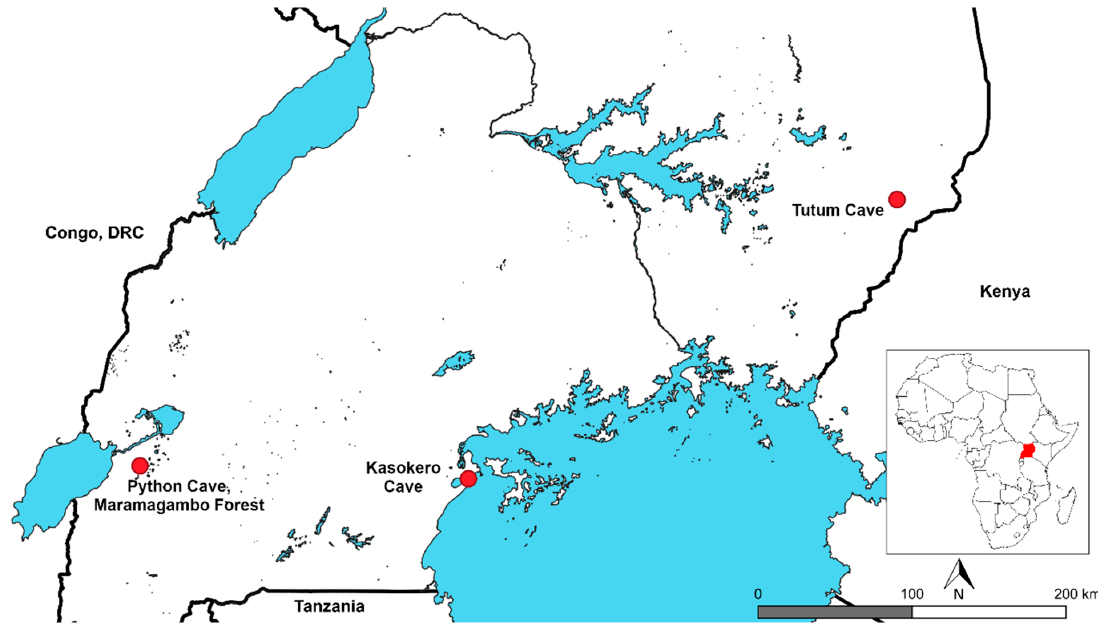
Figure 1. Sampling locations for bats within Uganda, 2009–2013. Capture locations for all bats tested in this study.